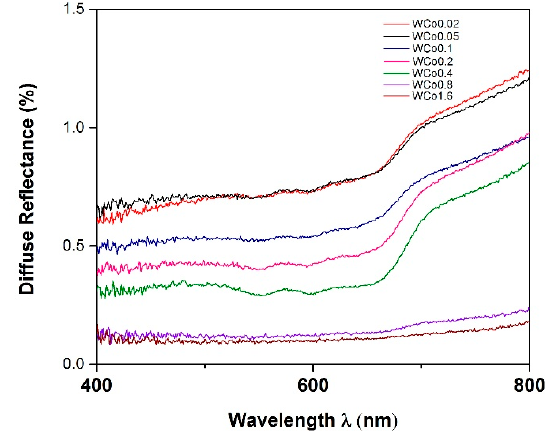
Figure 7. Diffuse reflectance spectra of Co x Mg (2 − x ) SiO 4 (where x = 0.02–1.6) synthesized by mirror waste calcined at 1000 °C for 2 h.